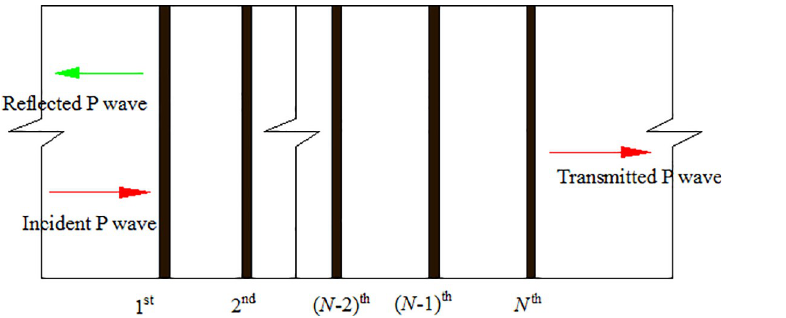
Fig 1. Incident P wave upon a rock mass with a set of parallel filled joints.